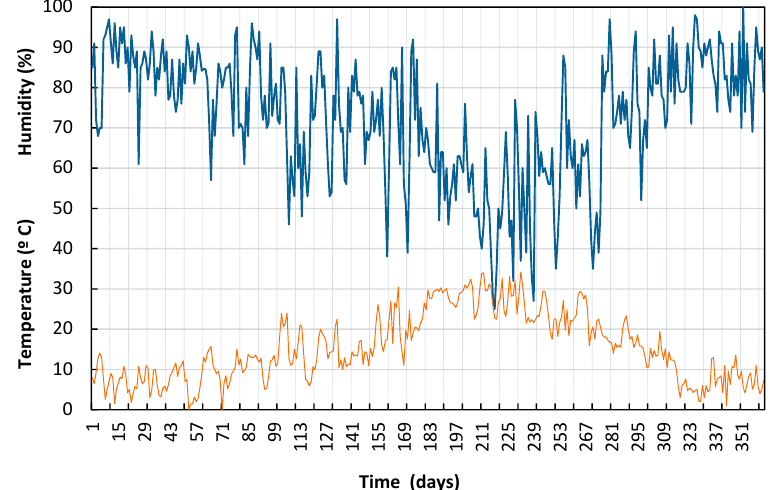
Figure 2. Graph of temperatures and humidity of the specimens during the shrinkage test.